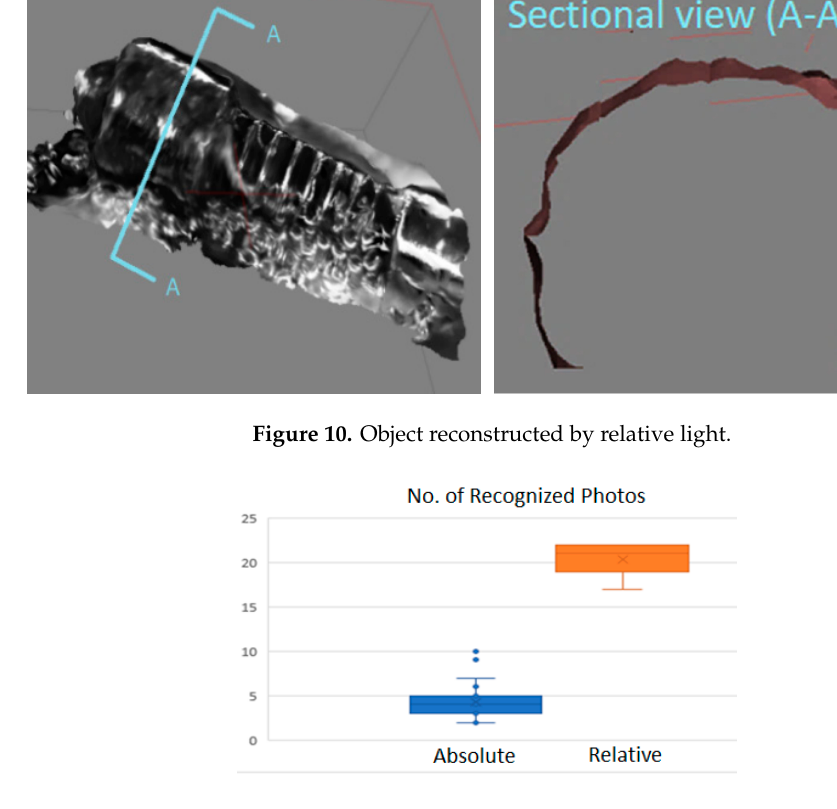
Figure 11. Photography recognition analysis.